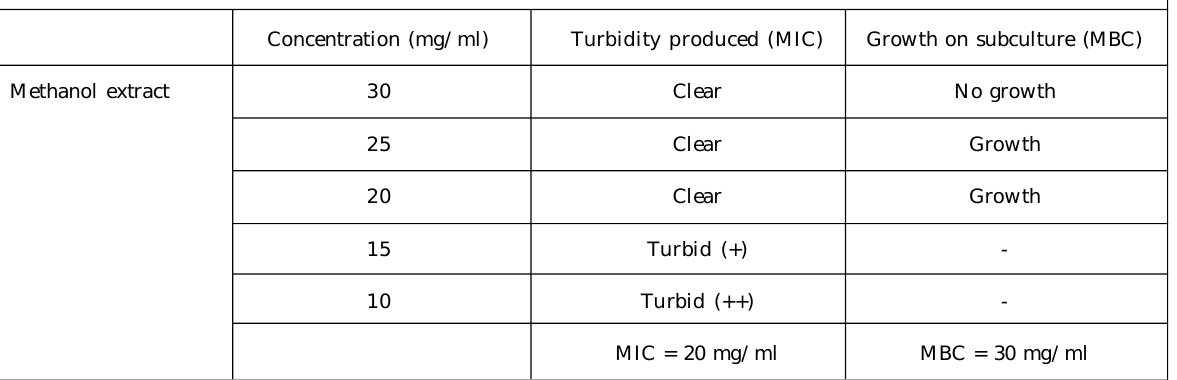
Table 3: The minimum inhibitory and bactericidal concentration of